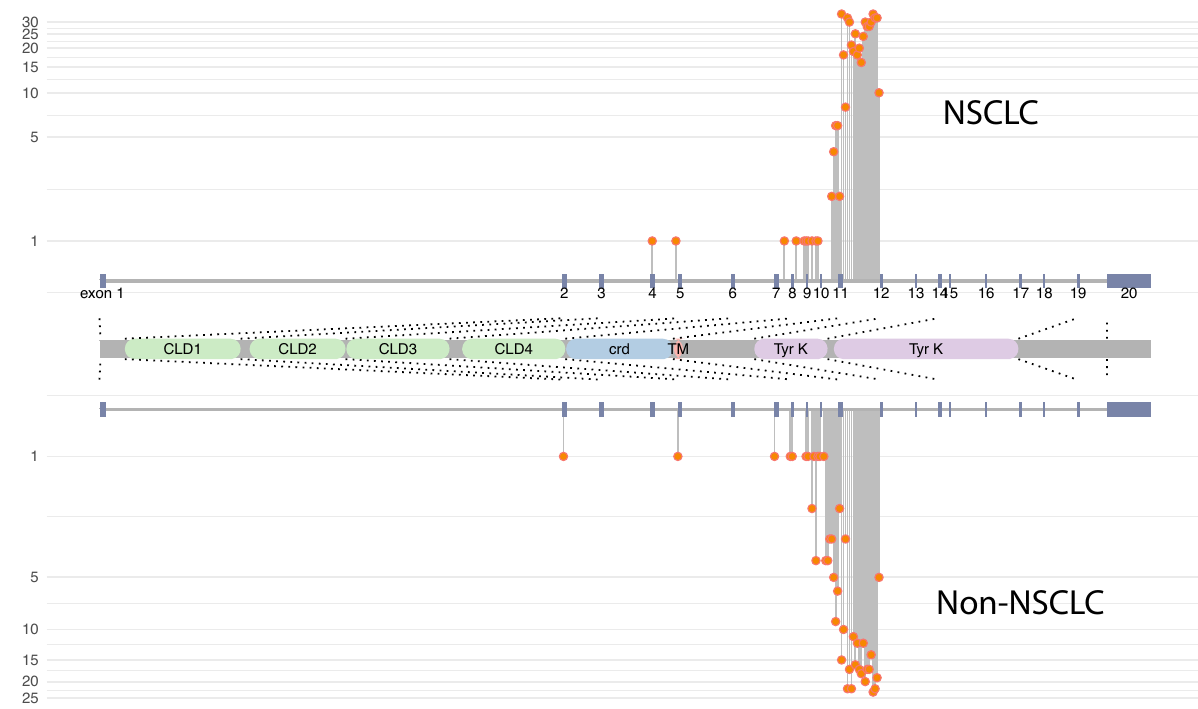
Fig. 2 RET gene breakpoints were mainly clustered in the intron 11 and there is no difference in the distribution of RET breakpoint regions between NSCLC and other solid tumors RET fusion-positive cohorts. Representative lollipop plot scheme of RET gene [Chr10 (10q11.21)] demonstrating the frequency of RET gene fusion breakpoints among advanced RET fusion-positive NSCLC and other solid tumors (excluding NSCLC). Gray horizontal line indicates RET gene introns. Blue vertical bars indicate RET gene exons. Coding region extending from 43,077,259 to 43,128,266. Orange lollipops indicate prevalence of RET breakpoints binned by 100 bases for analytical reasons. Among 891 RET fusion events, 87% of break points occurred in intron 11 followed by intron 10 (5%) and exon 11 (4.8%). No signi fi cant differences were observed among RET break point regions between NSCLC and other solid tumors. RET extracellular region is coded by exons 1 – 10 and part of exon 11 (aa 29 to 635) responsible for CLD1, CLD2, CLD3, CLD4, and CRD (responsible for physiological receptor dimerization). A transmembrane region is coded by part of exon 11 (aa 636-657). Bipartite protein tyrosine kinase domains are coded by part of exon 12, exons 13-18 and part of exon 19 (aa 658 to 1114). Abbreviations: Rearranged during transfection ( RET ). Non-small-cell lung cancer (NSCLC). Cadherin- like domain (CLD). Cysteine-rich domain (CRD). Transmembrane domain (TM). Cytoplasmic intrinsic tyrosine kinase domain (Tyr K). Amino acids differences in the higher TMB-H cases are likely due to the higher when compared to the RET fusion-negative colon adenocarci- proportion of MSI-H in the other solid tumor RET fusion noma cohort ( P < 0.05; Supplementary Table 9). positive cases. No cases had an MSI-H status in the overall NSCLC RET fusion- Co-NCCN guideline driver alterations among RET fusion positive positive cohort. In comparison, 219 (0.4%) NSCLC RET fusion- NSCLC . We examined RET fusion positive NSCLC for targetable negative cases were MSI-H and 29 (7.9%) other solid tumors RET co-alterations listed in the National Comprehensive Cancer fusion-positive cases were MSI-H (Tables 1 – 2 ) . Of note, 41.7% Network (NCCN) Guidelines. The speci fi c NCCN genomic altera- tions that we examined were sensitizing EGFR mutations, KRAS (25/60) of the RET fusion-positive colon adenocarcinomas had an G12C, BRAF V600E, ERBB2 mutations, and MET exon 14 skipping MSI-H status which was signi fi cantly higher than the RET fusion mutations, ALK and ROS1 rearrangements, NTRK fusions and MET negative colon adenocarcinoma (5.5%, 1805/32,938) ( p < 0.001) ampli fi cations. Overall, only 34 cases had co-occurring NCCN- (Supplementary Table 4). This same trend was seen in the NSCLC driver alterations. These included EGFR (3%, 17/223), KRAS prevalence of TMB-H status in colon adenocarcinoma (51.7% (3%, 14/223), and BRAF (1%, 3/223). [31/60] vs 9.3% [3075/32,938], p < 0.001). Among 141 RET fusion-positive NSCLC cases where we had Immune checkpoint inhibitor biomarkers . We examined immune also performed the PD-L1 22C3 CDx assay, 22% (31/141) had a checkpoint inhibitor (ICPI) biomarkers based on CGP and PD-L1 negative TPS score (TPS < 1%), 42% (59/141) had a low positive IHC. The NSCLC RET fusion-positive cohort had a signi fi cantly TPS score (TPS 1 – 49) and 36% (51/141) had a high positive score lower number of TMB-H cases and median TMB when compared (TPS ≥ 50). PD-L1 tumor cell expression in the NSCLC RET fusion- to the NSCLC RET fusion-negative cohort ( P < 0.001; Table 2). In positive cohort was signi fi cantly higher than in the NSCLC RET comparison to the NSCLC RET fusion-positive cohort, the other fusion-negative cohort ( P < 0.001) (Table 2). Of note, while DAKO solid tumors RET fusion-positive cohort had a signi fi cantly higher 22C3 TPS is not a CDx in other solid tumors, we had 95 RET proportion of TMB-H cases, though the median TMB did not fusion-positive other solid tumor cases ran with the DAKO 22C3 differ signi fi cantly ( P < 0.001 & P = 0.741, respectively; Table 1). and scored with TPS. In the other solid tumors cohort, 60% (57/ For the NSCLC RET fusion positive cases, 0% (0/27) TMB-H were 95) had a negative TPS score (TPS < 1%), 25% (24/95) had a low MSI-H; and for the other solid tumor RET fusion positive cases, positive TPS score (TPS 1 – 49) and 15% (14/95) had a high 53.3% (24/45) TMB-H were also MSI-H. This suggest that the positive score (TPS ≥ 50; Table 1).